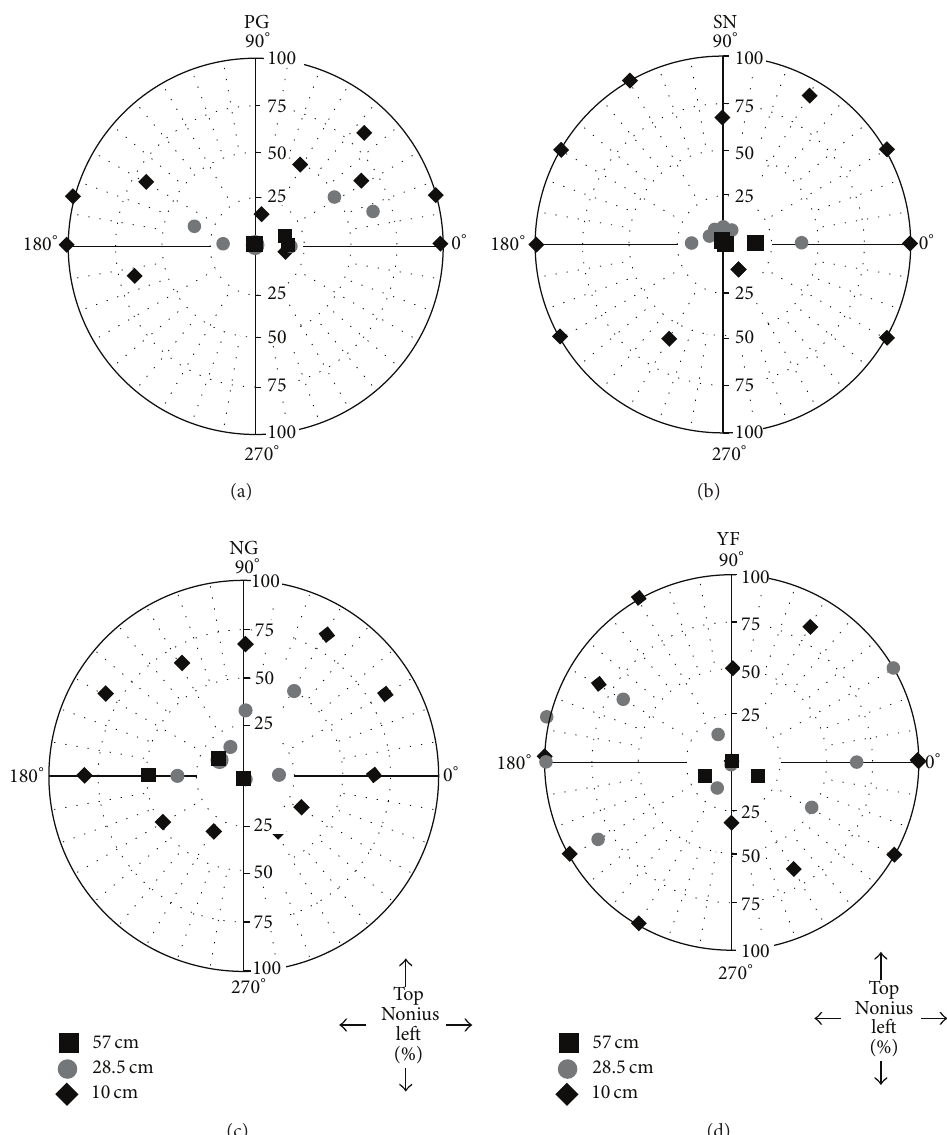
Figure 10: Individual polar plots indicating the percentage of trials; the Nonius lines appeared misaligned with the top line displaced towards the left for each radius. Percentage is plotted along vertical radii; radius angles are plotted around the